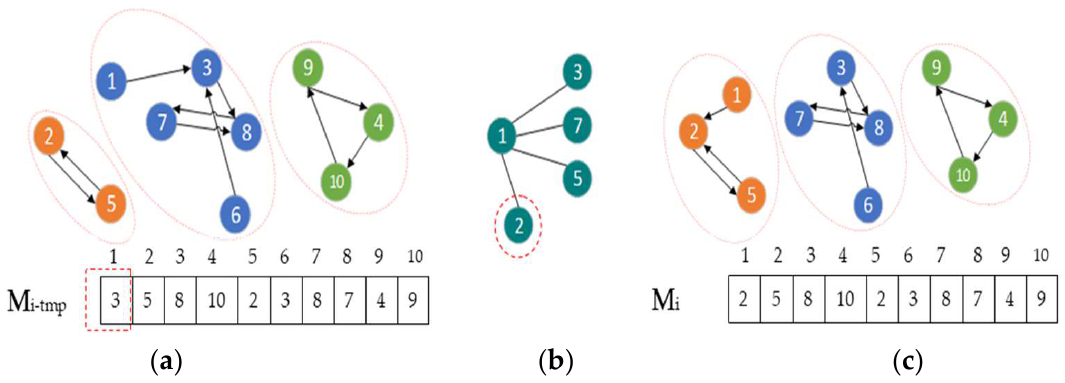
Figure 8. Updating Mi using the single-point neighbor-based mutation: ( a ) randomly selecting a node; ( b ) randomly selecting a neighbor; ( c ) replacing value of selected node using its selected neighbor.